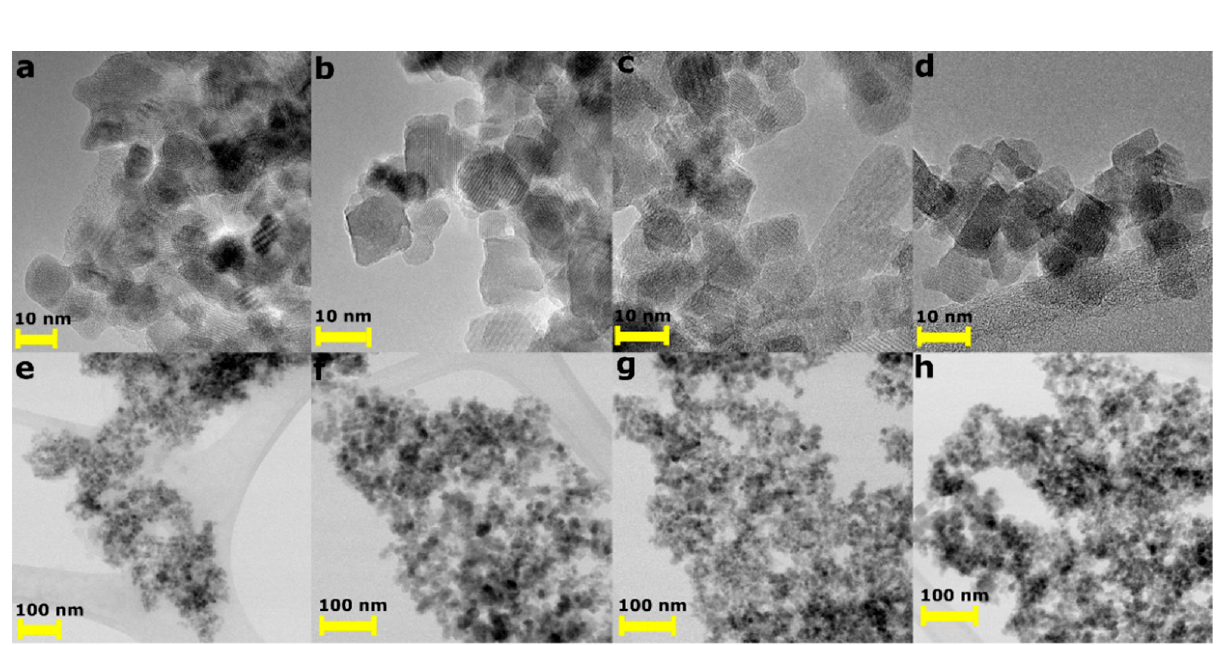
Figure 2. Transmission electron microscopy images of magnetite nanoparticles synthesized without ( a , e ) and with the presence of en ( b , f ), ClT ( c , g ), and PPh 3 ( d , h ).